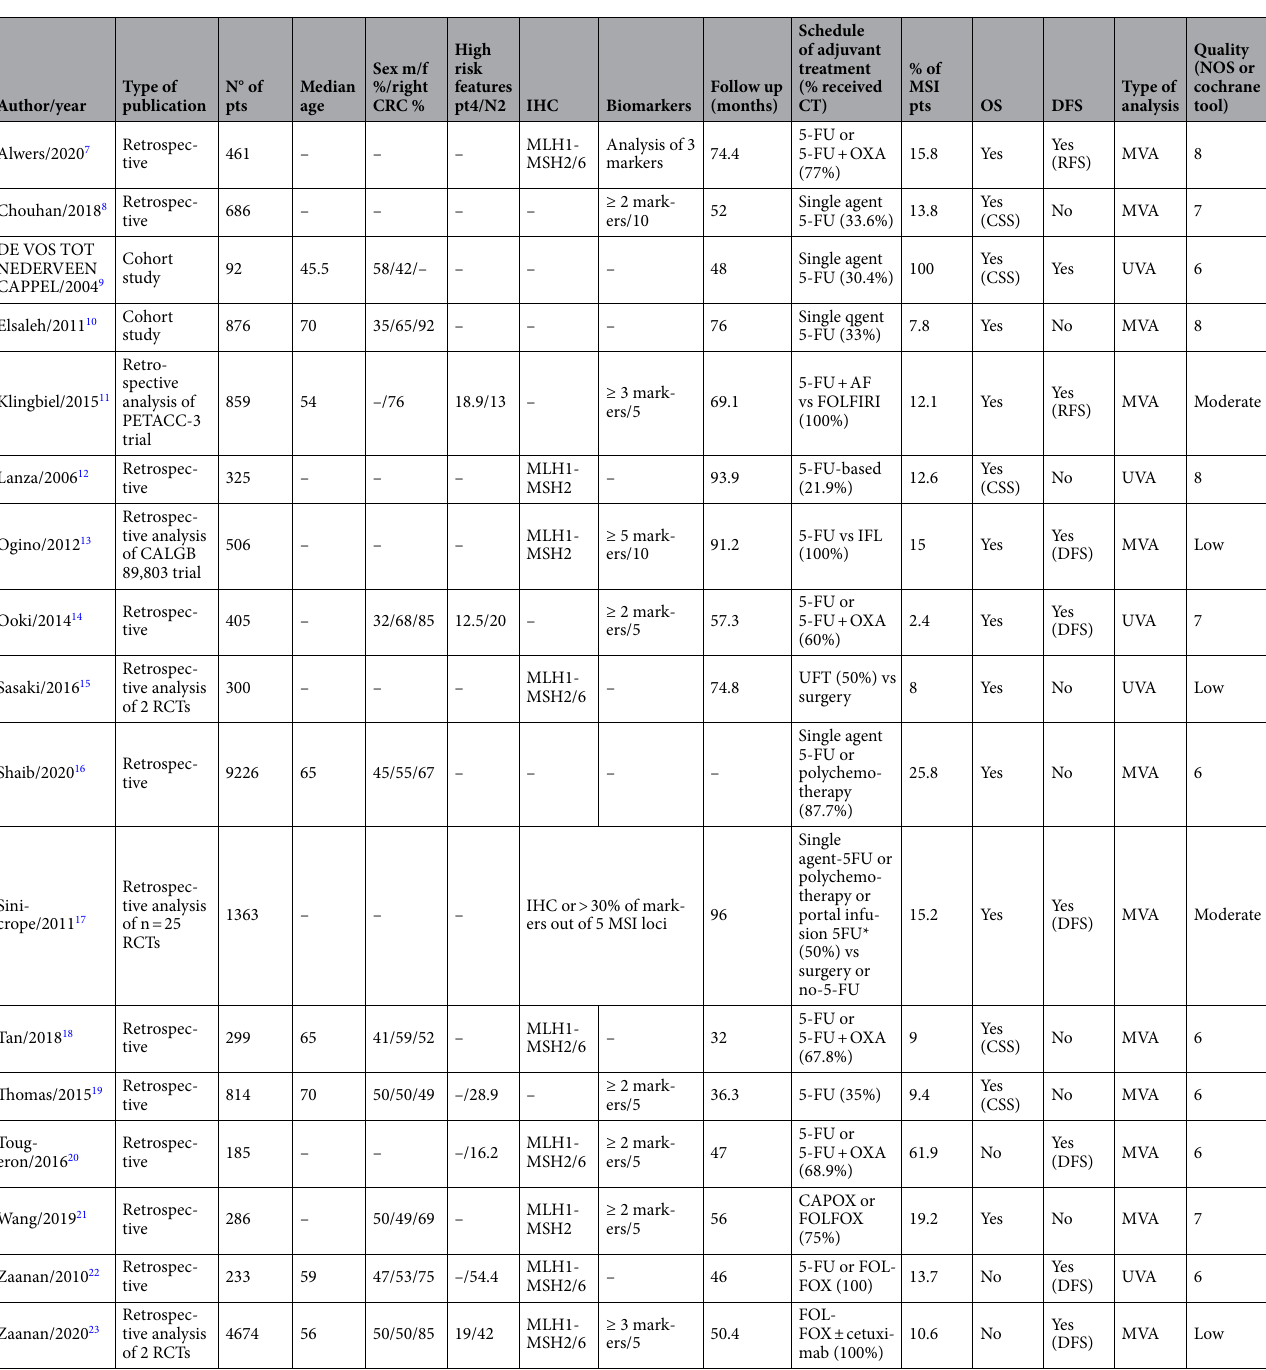
Table 1. Characteristics of included studies. *Not containing oxaliplatin or 5FU, °All stage III patients, IFL irinotecan + bolus 5FU + bolus leucovorin, AF folinic acid, UFT uracil + ftorafur, CSS cancer-specific survival, M male, F female, CRC colorectal cancer, pts patients, UVA univariate analysis, MVA multivariate analysis, NOS Nottingham-Ottawa scale, OS overall survival, DFS disease-free survival, MSI microsatellite instability, − not available or not